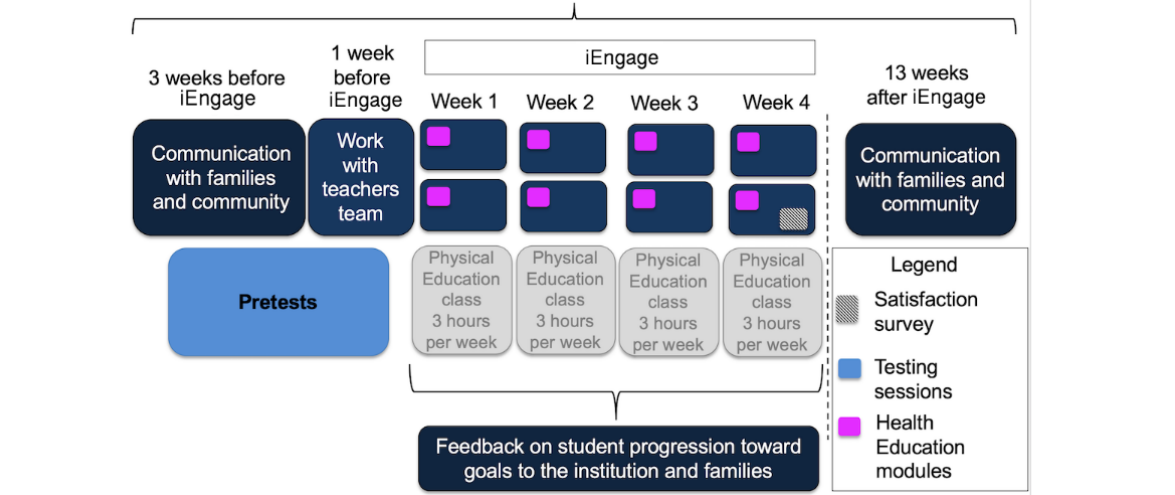
Figure 1. Study design. Pretests and communication with families began 3 weeks before the start of the educational program; coordination with the teaching team was finalized 1 week prior, along with baseline measures. The digital program lasted for 4 weeks, with biweekly health education modules held in class (in pink). Feedback to families about the program occurred in the week following the end of the